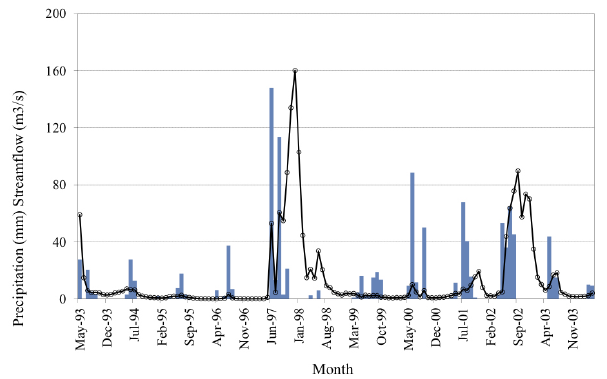
Fig. 4. Phased transfer of water from Imperial Irrigation Dis- trict to urban uses, 2003–2077. Source: http://www.sdcwa.org/